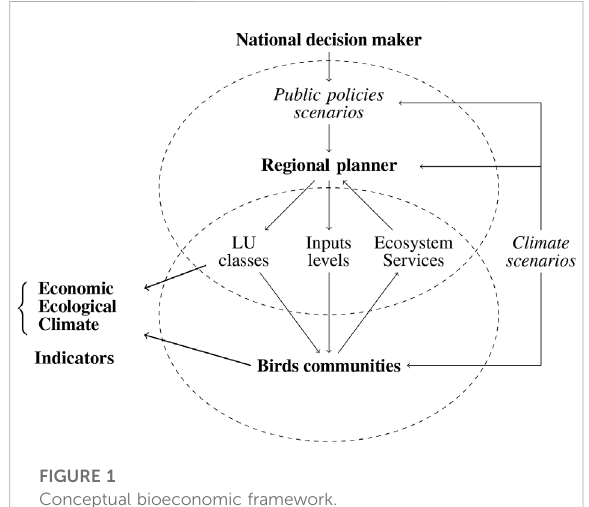
FIGURE 1 Conceptual bioeconomic